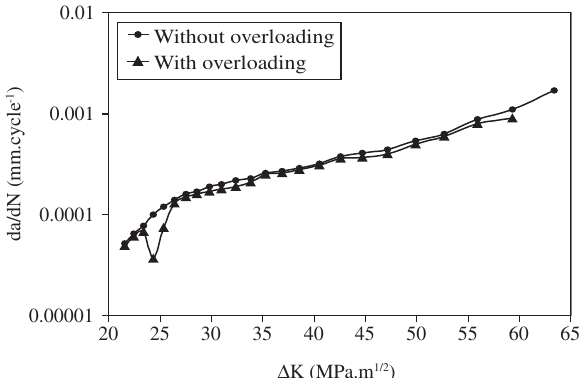
Figure 5. da/dN vs. ∆ K for BH microstructural condition after an overload of 13.5 kN.